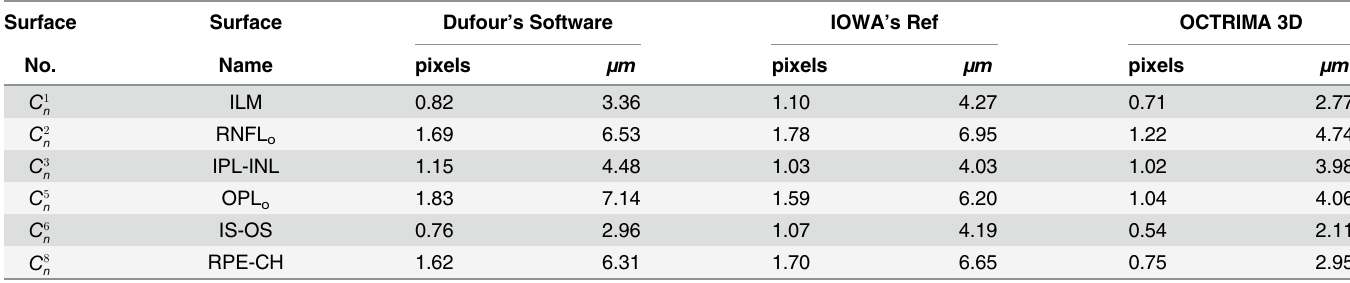
Table 2. Comparison of average absolute detection error in unit of pixels and microns between Dufour ’ s algorithm, IOWA Reference Algorithm and OCTRIMA 3D in ETDRS region. Surface Surface Dufour ’ s Software IOWA ’ s Ref OCTRIMA 3D